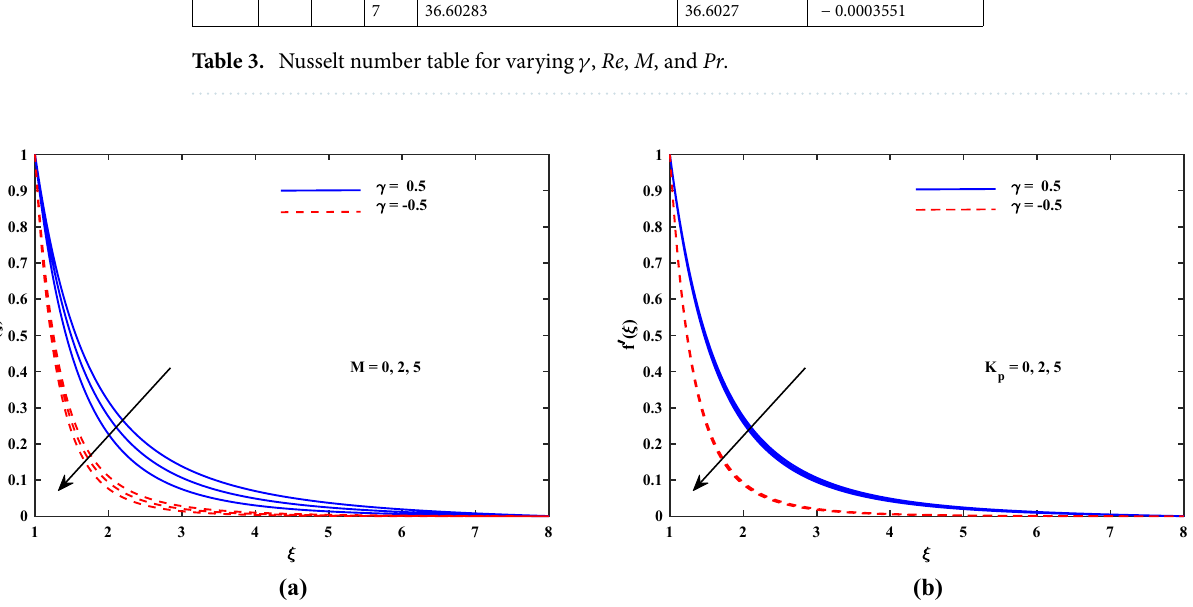
Figure 2. Plot for velocity profile f ′ (ξ) with varying values of M and K p